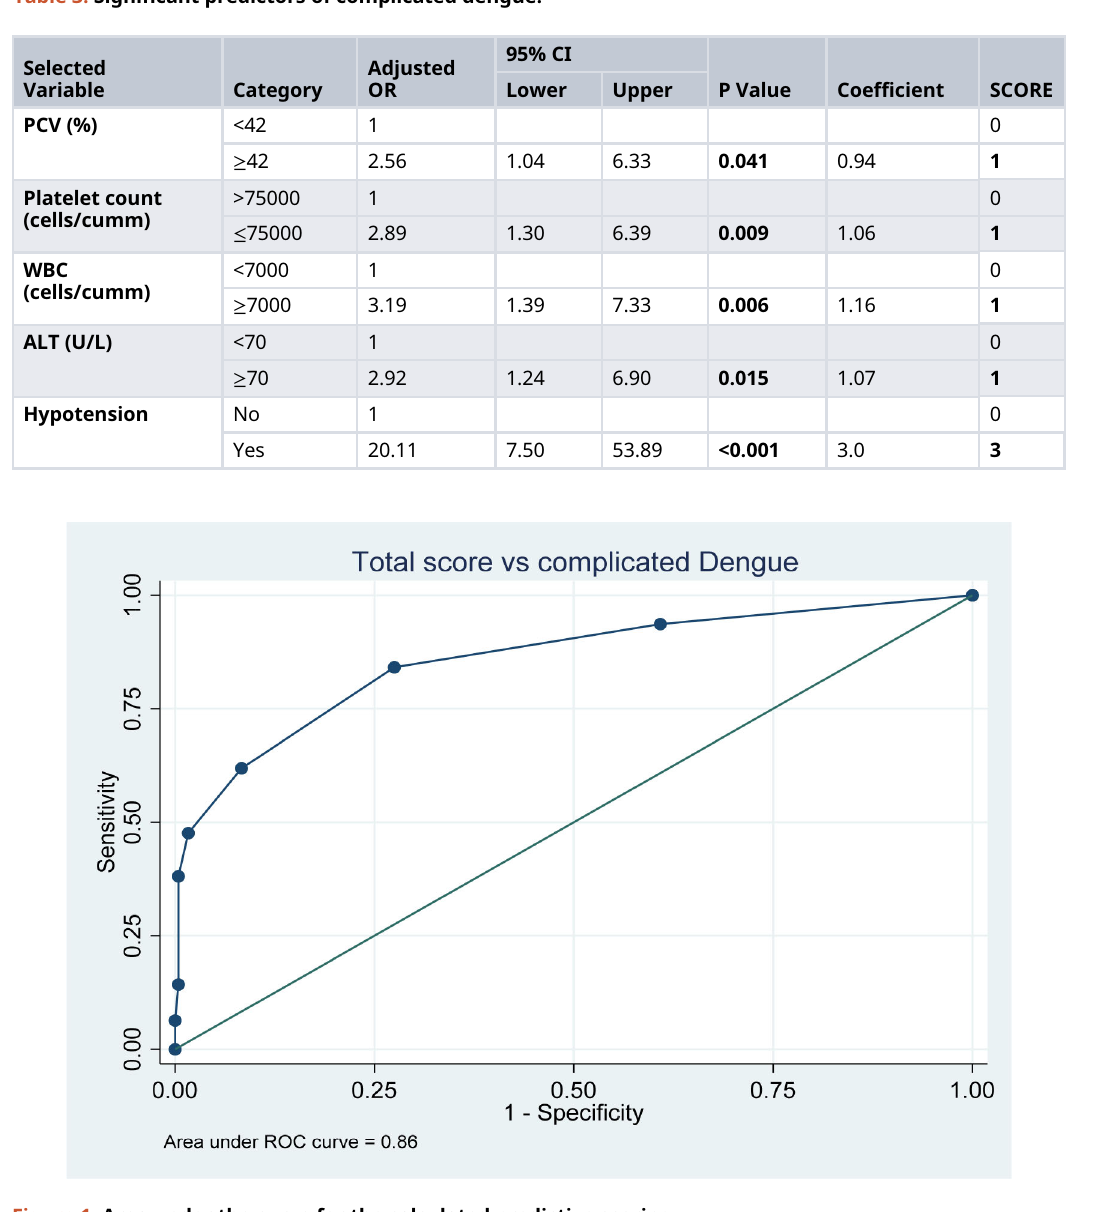
Table 3. Significant predictors of complicated dengue.